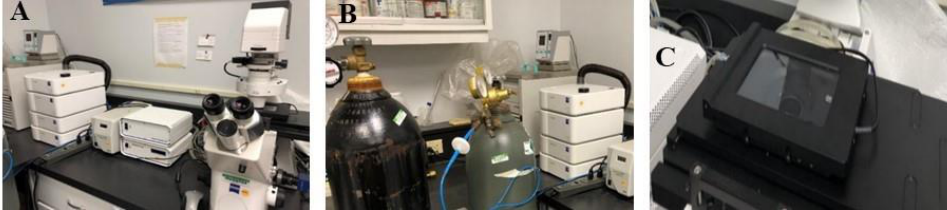
Figure 3. A complete fluorescent microscope setup is shown. ( A ) Set-up of the Zeiss Axio observer Z1 epifluorescent microscope, ( B ) 100% CO 2 and N 2 gas tanks and mixing modules and, ( C ) incubation chamber.